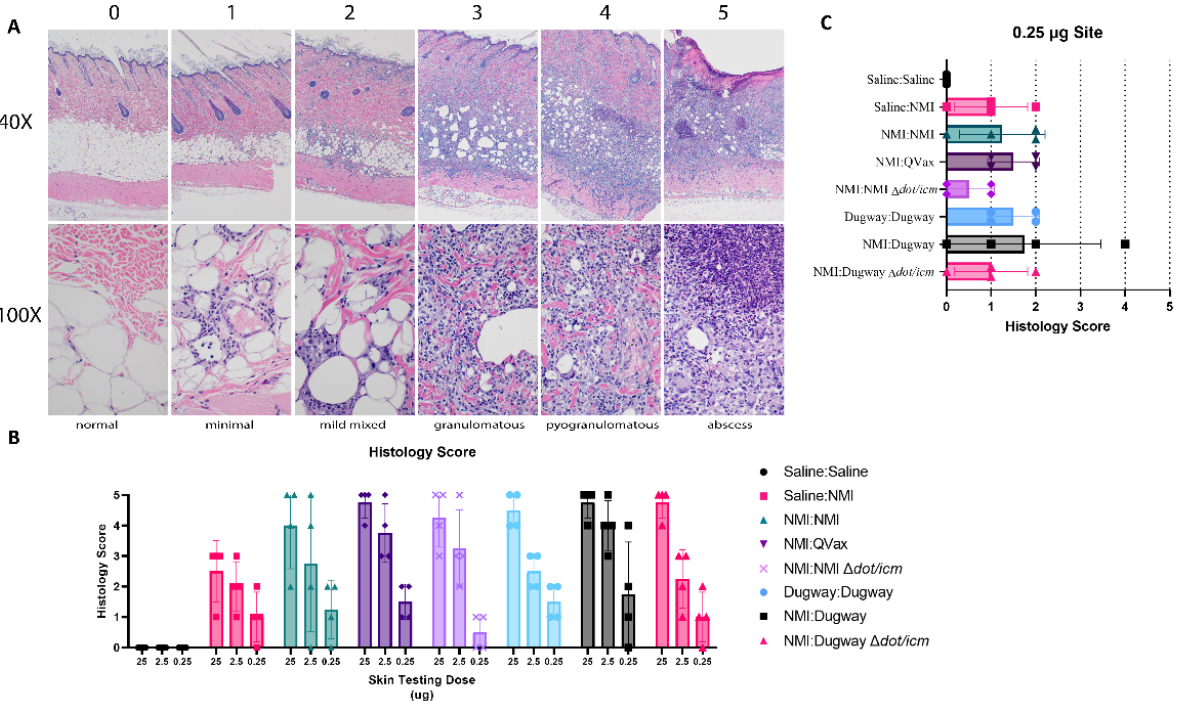
Figure 5. Low-dose skin testing inflammatory responses are reduced following ∆ dot/icm whole-cell vaccination. Skin-testing site biopsy histological scoring is outlined in ( A ) with inflammatory score (0–5), magnification (40×, 100\×), and brief description denoted. Guinea pigs are identified as fol-